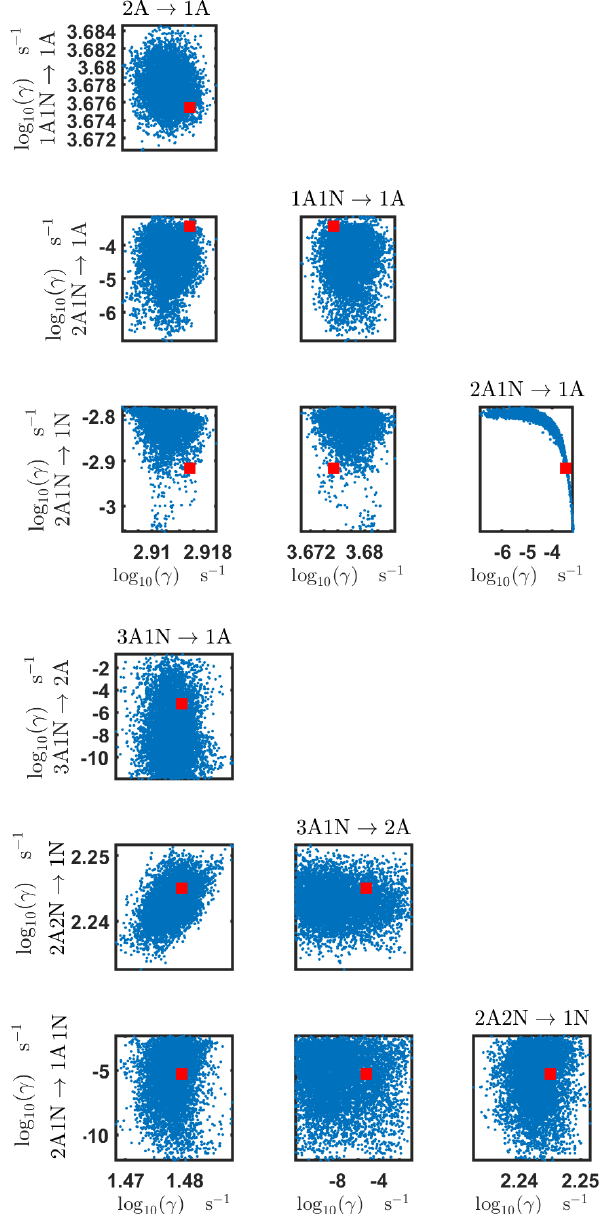
Figure B4. Pairwise marginal posterior distributions (for parameter indexes ranging from 9 to 16) of the base 10 logarithm of the evapo- ration rates (units given in s − 1 ) determined from steady-state cluster concentration measurements at the temperature 278K. Red rectan- gles denote the baseline values from Olenius et al. (2013b) used to generate the synthetic data. The notation xAyN corresponds to a cluster with x sulfuric acid and y ammonia